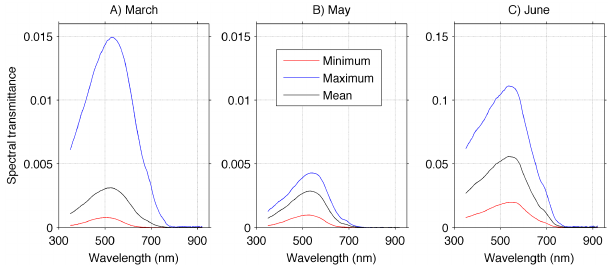
Fig. 5. Spectral transmittance through snow and sea ice in (a) March, (b) May, and (c) June 2010. For each transect the spectra for minimum and maximum light conditions as well as the mean spectrum for the transect are given. Note different scales (factor 10) for the data in